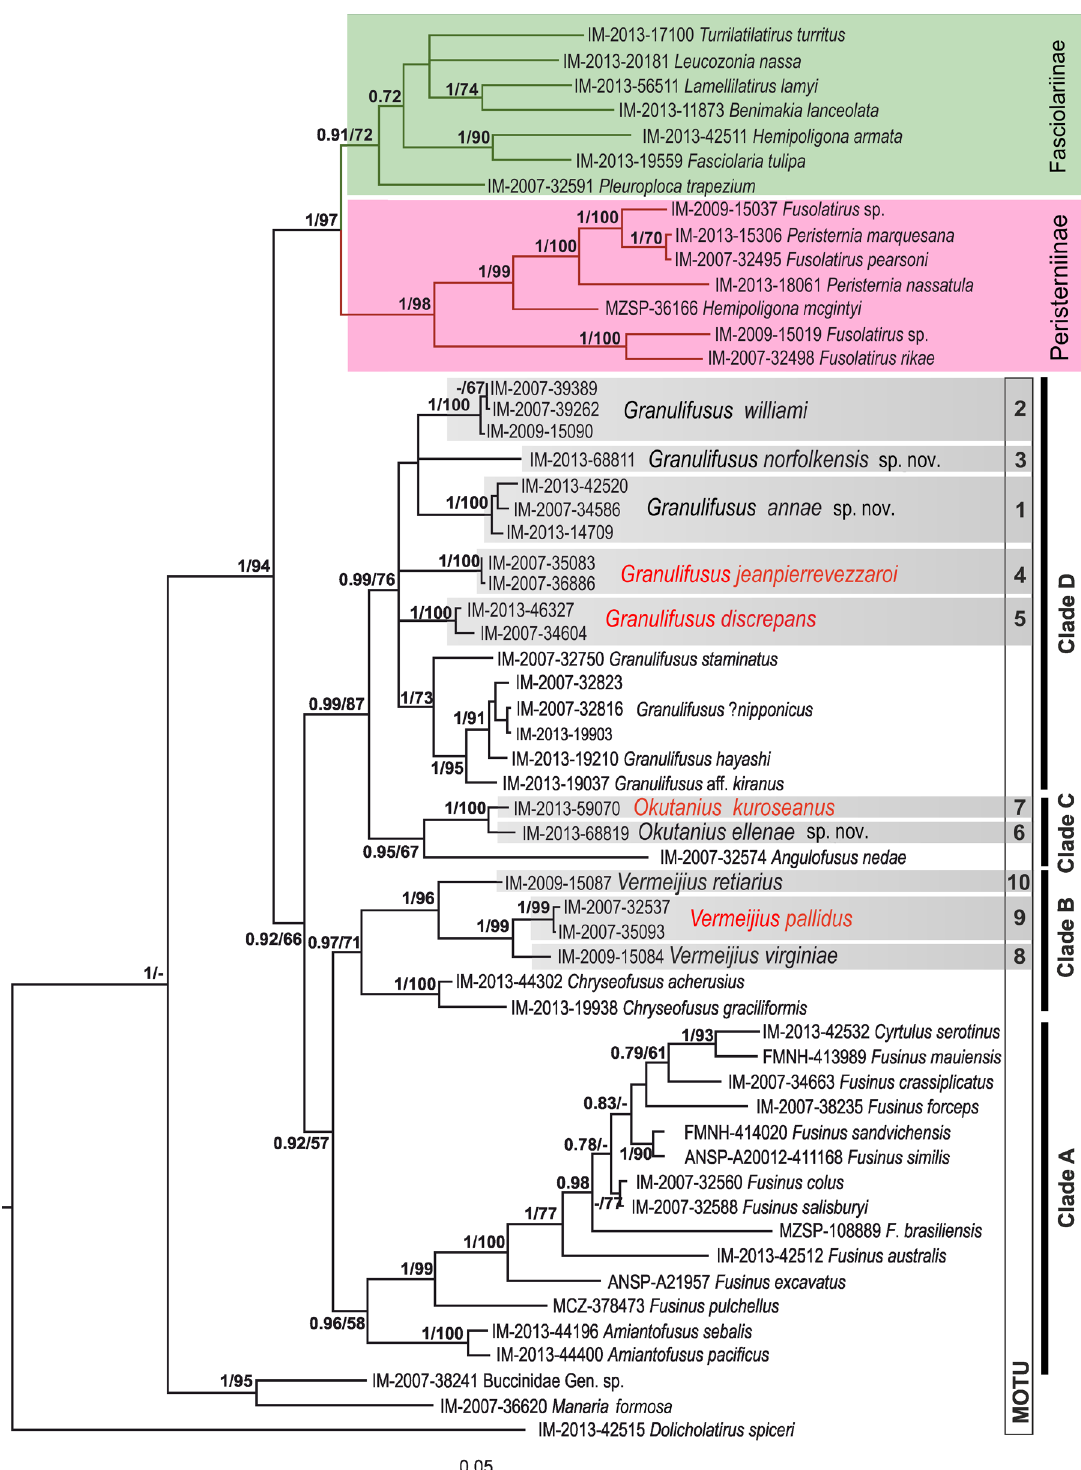
Fig. 2. Bayesian phylogenetic tree of Fasciolariidae based on the combined COI-H3-28S dataset. Subclades corresponding to Couto et al .’s (2016) Fasciolaria tulipa clade (Fasciolariinae) and Peristernia nassatula clade (Peristerniinae) are marked with green and pink, respectively. MOTUs identified in the current study are highlighted in grey. The numbering of MOTU correspond to Fig. 1. Support values as Bayesian posterior probabilities (PP) indicated when > 0.7 / bootstrap values, when >